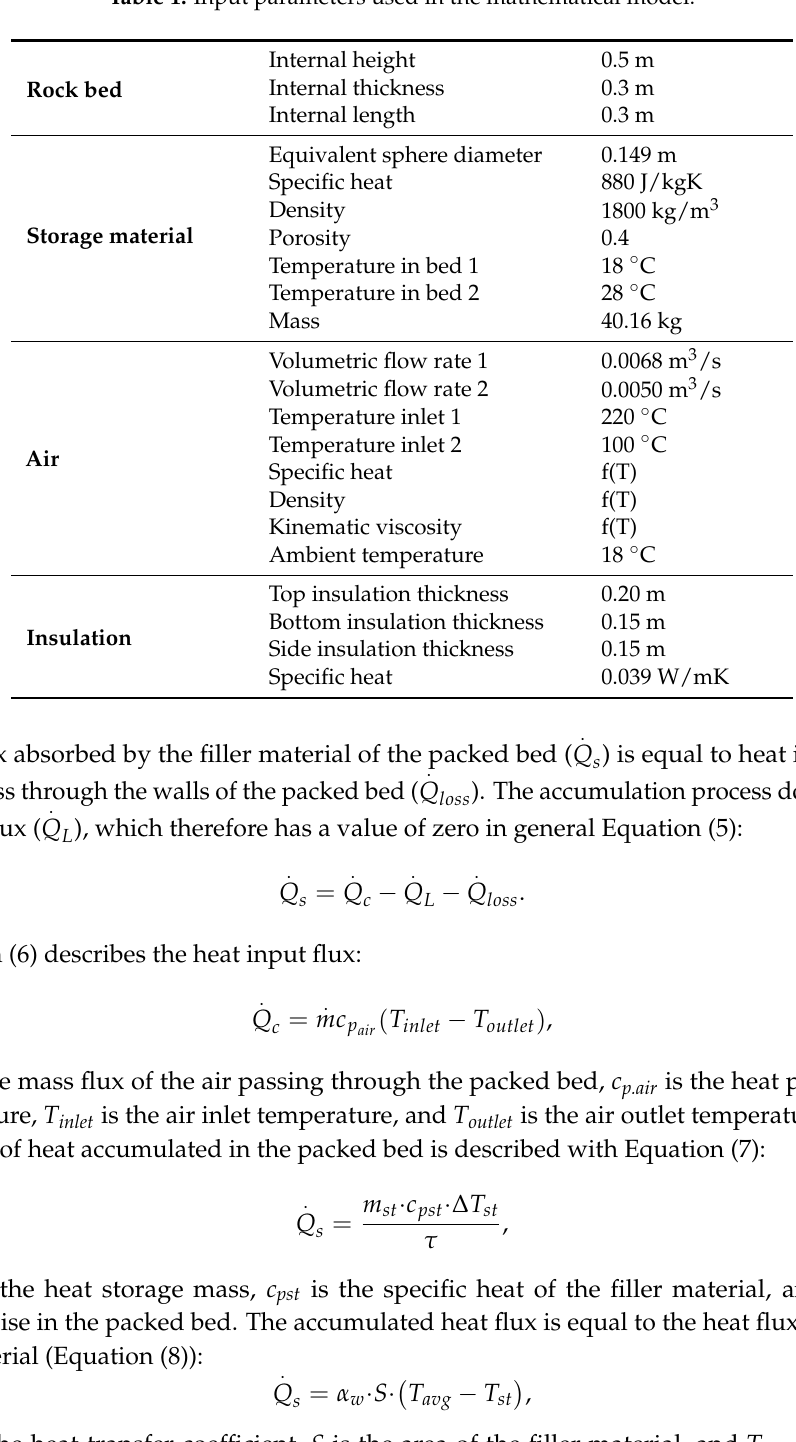
Table 1. Input parameters used in the mathematical